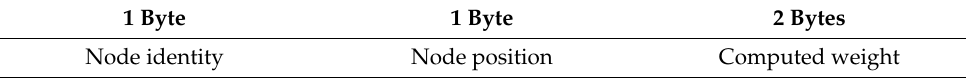
Table 1. Format of the edge records. 1 Byte 1 Byte 2 Bytes Node identity Node position Computed